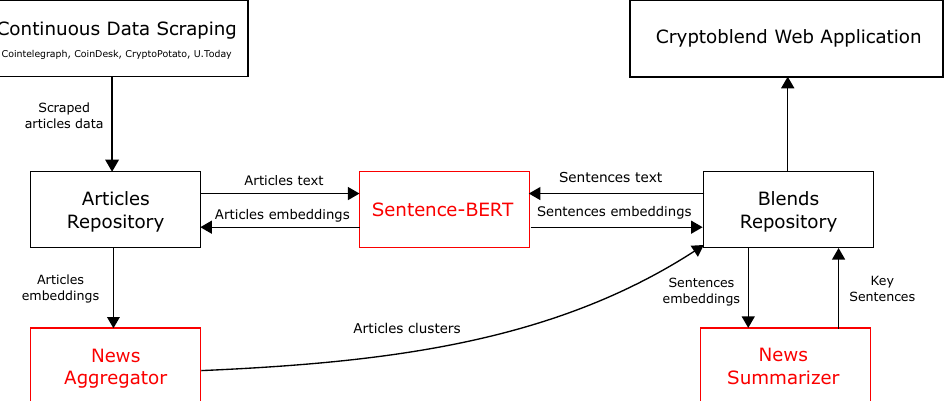
Figure 1. Conceptual scheme of the proposed methodology. Note that the module depicted in the upper-left corner (Continuous Data Scraping) implements the methodology described in Section 3.1, while the blocks highlighted in red correspond to those detailed in Section 3.2. Finally, the module in the upper-right corner (Cryptoblend Web Application) refers to the web application presented in Section